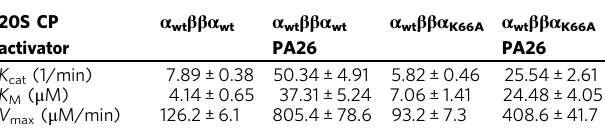
Table 2 Table summarizes the k cat (1/min), K M ( μ M), and μ M/min) kinetic parameters of peptidase activity of V max ( symmetric and asymmetric 20S CP without and with PA26 activator.